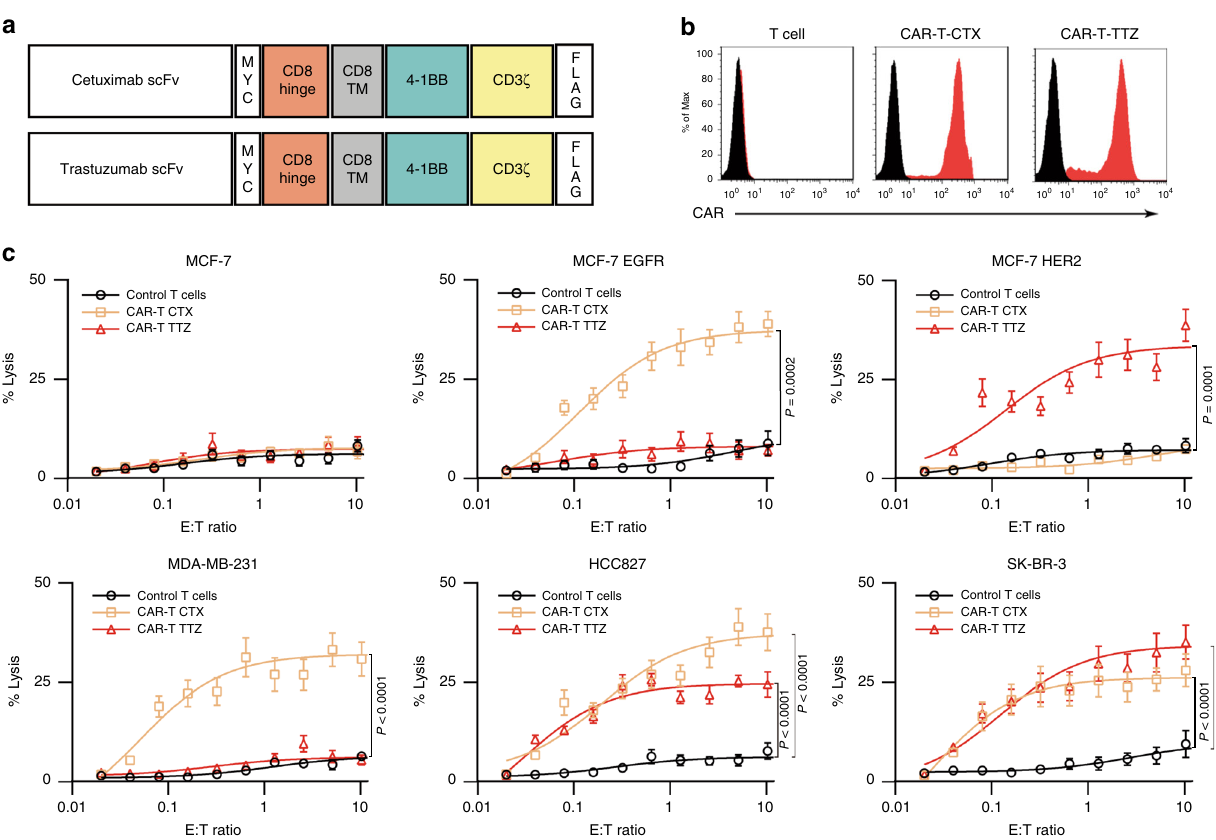
Fig. 1 Generation and characterization of CAR-T cells. a Vector maps of tested CAR designs. b Membrane-bound CAR expression. Forty-eight hours after retroviral transduction, the expression of CAR on human T cells was detected by staining with anti-MYC antibody, followed by fl ow cytometry analysis. T cells without transduction were used as a negative control. The histograms shown in black correspond to the isotype controls, whereas the red histograms indicate the positive fl uorescence. c Killing activity of CAR-T cells in response to tumour cells. The cytotoxic activity of CAR-T and control T cells against cancer cell lines was assessed by a 51 Cr-release assay at the indicated effector-to-target (E:T) ratios. Results shown represent three ( b ) independent experiments. Data are means ± s.d. of fi ve ( c ) independent biological replicates. P values are from a two-way ANOVA followed by